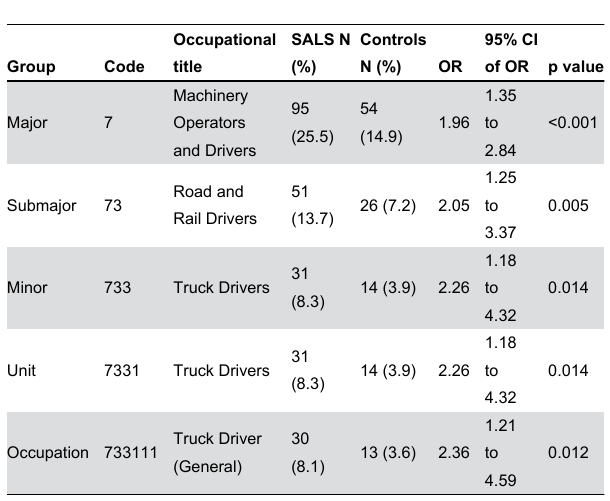
Table 2. SALS risk in ANZSCO male truck drivers. Table 3. Occupations (ANZSCO group 5) and other occupational groups (ANZSCO groups 1-4) at risk of